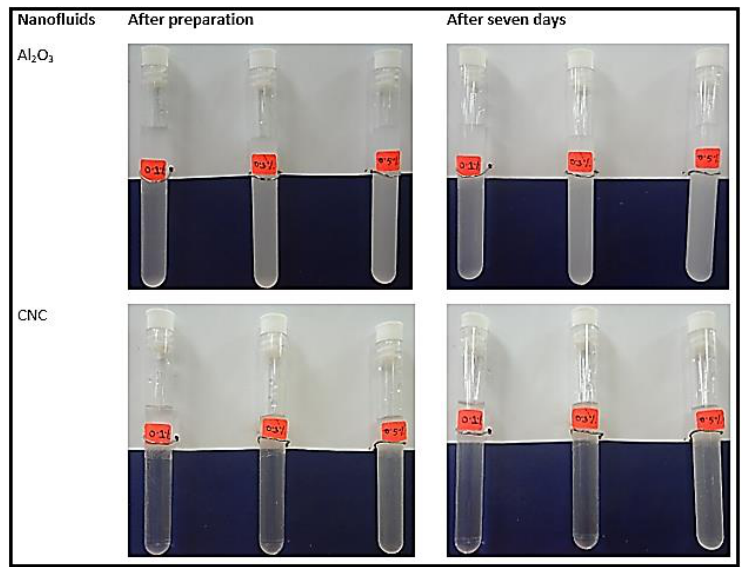
Figure 5. Evaluation of qualitative stability measurement of nanofluids [42].